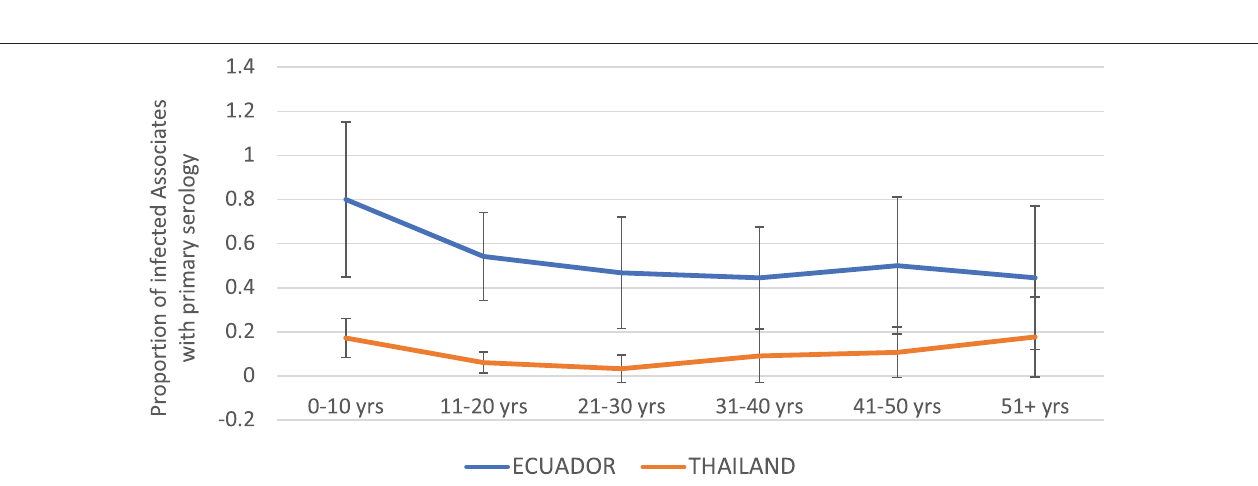
FIGURE 3 | Proportion of Associates confirmed to have DENV infection, by age and study site. Thailand is shown in orange and Ecuador in blue. Error bars reflect the 95% confidence intervals for the proportions.